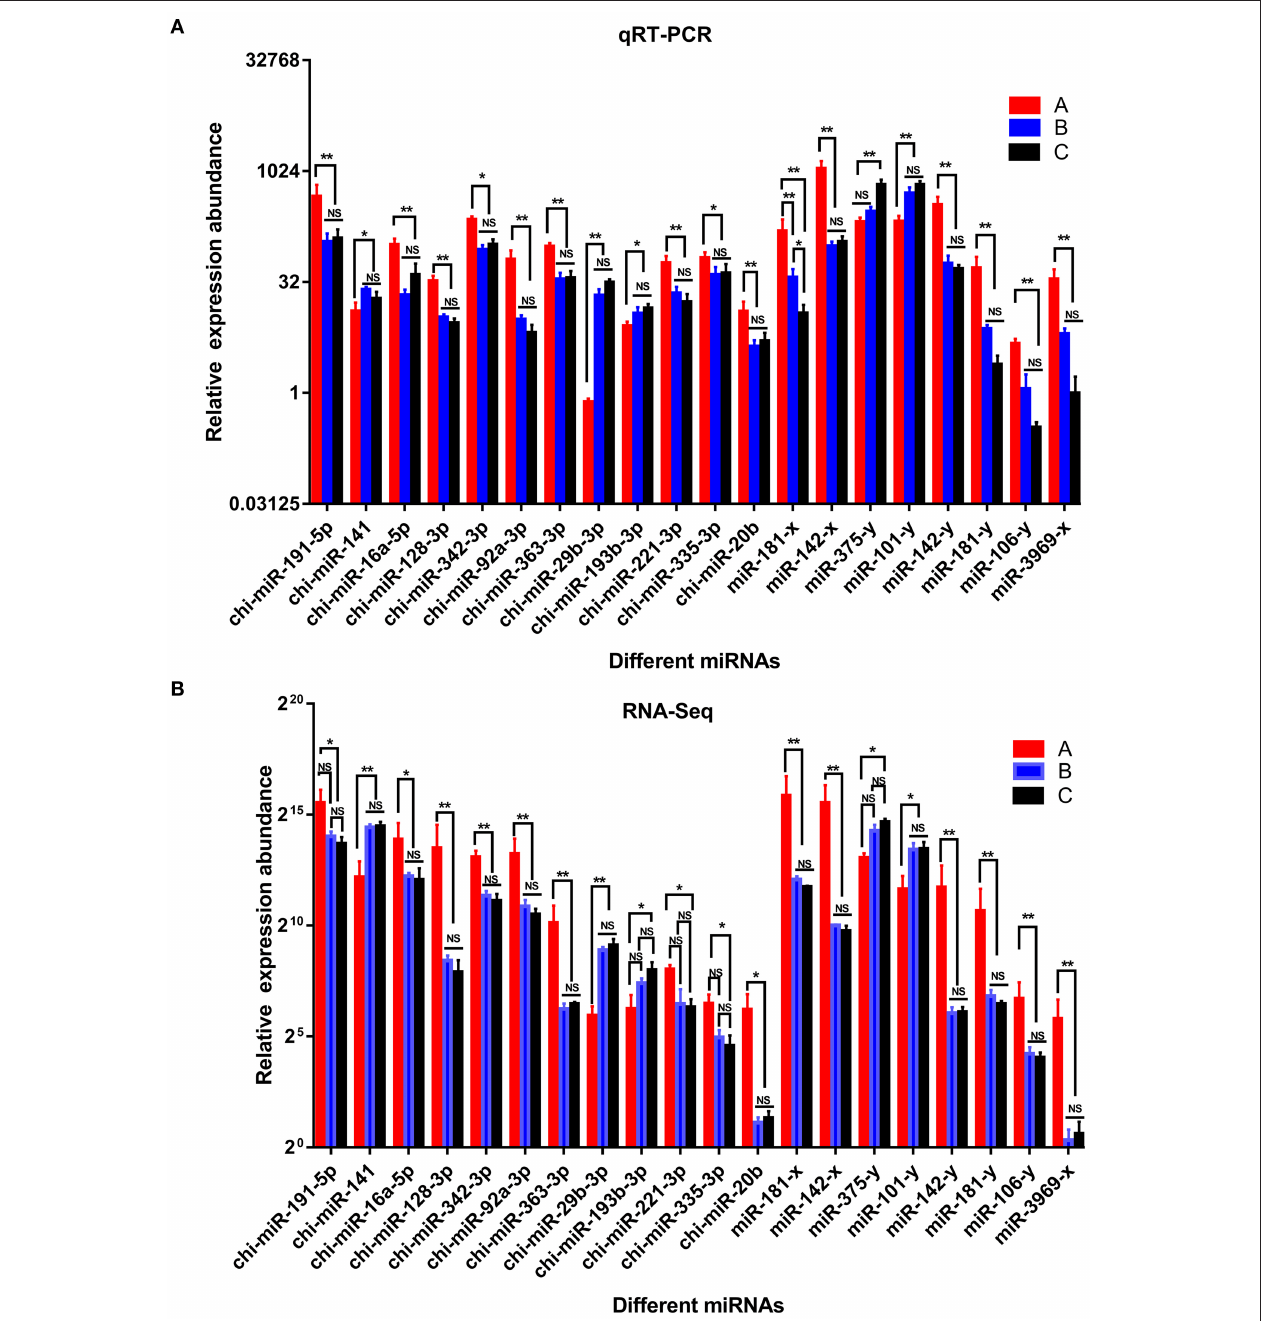
FIGURE 7 | Comparison of relative expression of DE miRNAs between RNA-Seq and qRT-PCR results. (A) the results of qRT-PCR, (B) the results of RNA-seq. A were the samples for goat of 1-month-old kids (group A), B were the samples for goat of 12-month-old maiden goats goats (group B), C were the samples for goat of 24-month-old adult goats (group C). Significant differences are indicated by * and ** (* indicates p < 0.01, ** indicates p < 0.05), NS indicates there is no significant